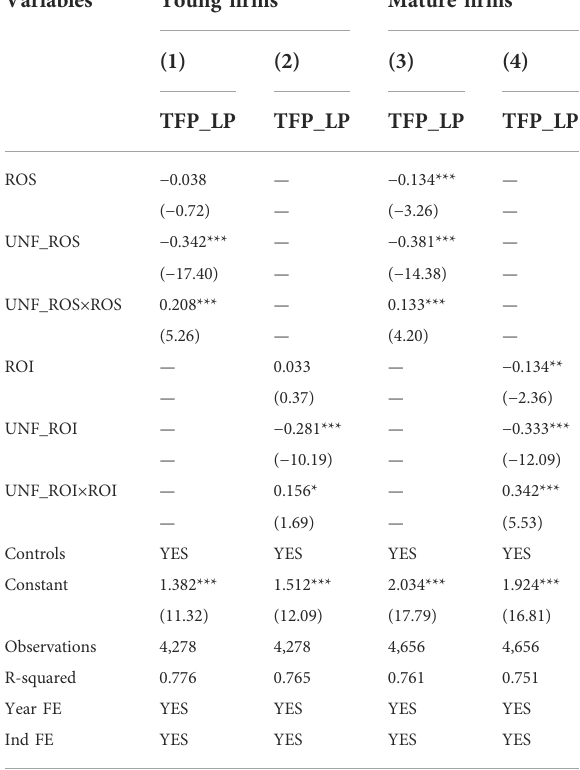
TABLE 13 Heterogeneity tests for different life cycle stages. Variables Young fi